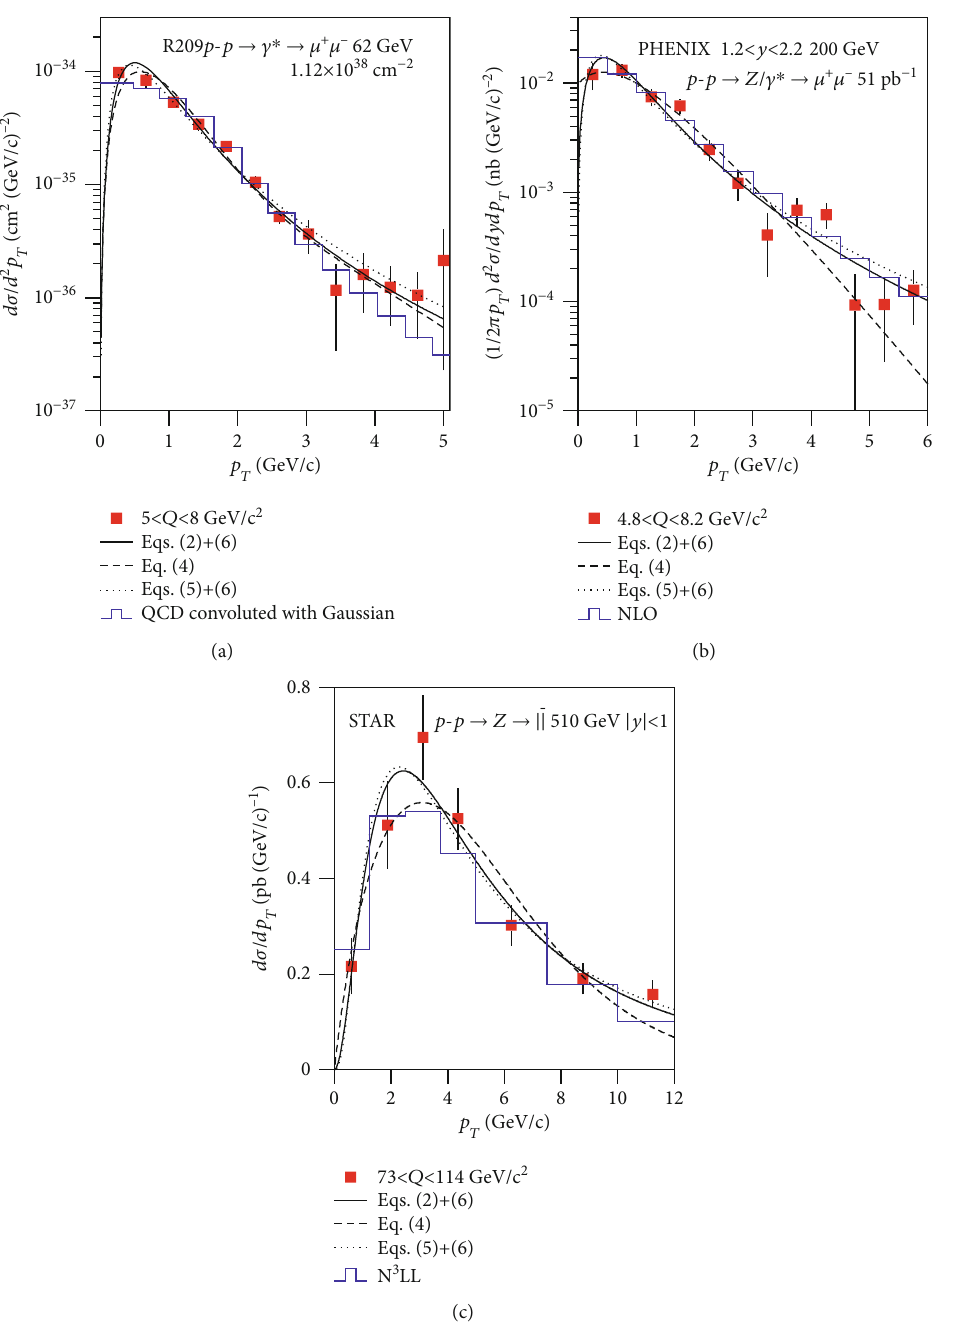
Figure 2: Transverse momentum spectra of ℓ (cid:1) ℓ (with di ff erent invariant masses Q ) produced by the Drell-Yan process in pp collisions at ffiffi p s = 62 (a), 200 (b), and 510GeV (c). The data points are quoted from the R209 (a) [46], PHENIX (b) [47], and STAR Collaborations (c) (cid:1) ℓ [24]. In panels (a) and (b), ℓ is μ + μ − . The solid, dashed, and dotted curves are our results of fi tting the data points with the convolution of two Lévy-Tsallis functions [Eqs. (2) and (6)], the two-component Erlang distribution [Eq. (4)], and the convolution of two Hagedorn functions [Eqs. (5) and (6)], respectively, see text in subsection 3.3 for the meanings of histograms which are quoted from QCD